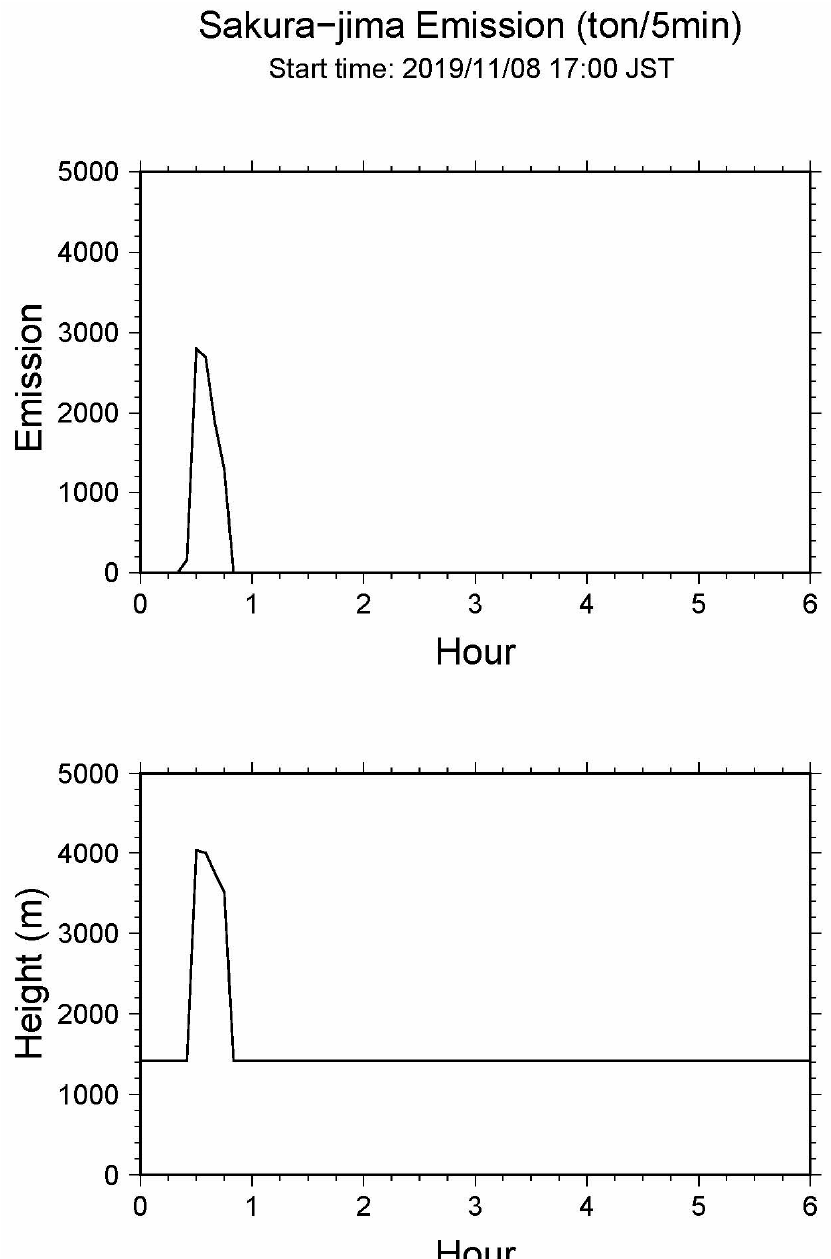
Figure 2. Time series of the emission rate (ton/5min) and the corresponding plume height (m) estimated by Equation (2) as the input for the PUFF model. The simulation started at 17:00 JST (8:00 a.m. coordinated Universal Time, UTC) and ended at 23:00 JST (14:00 UTC). The simulation interval is noted from 0 to 6 h in the abscissa.